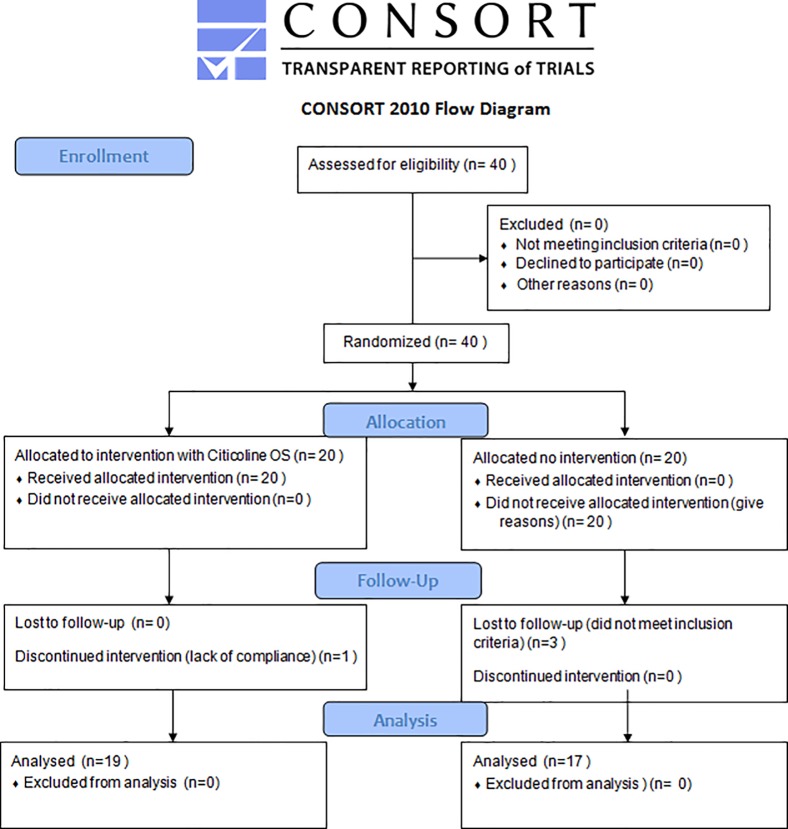
CONSORT participant flow diagram.